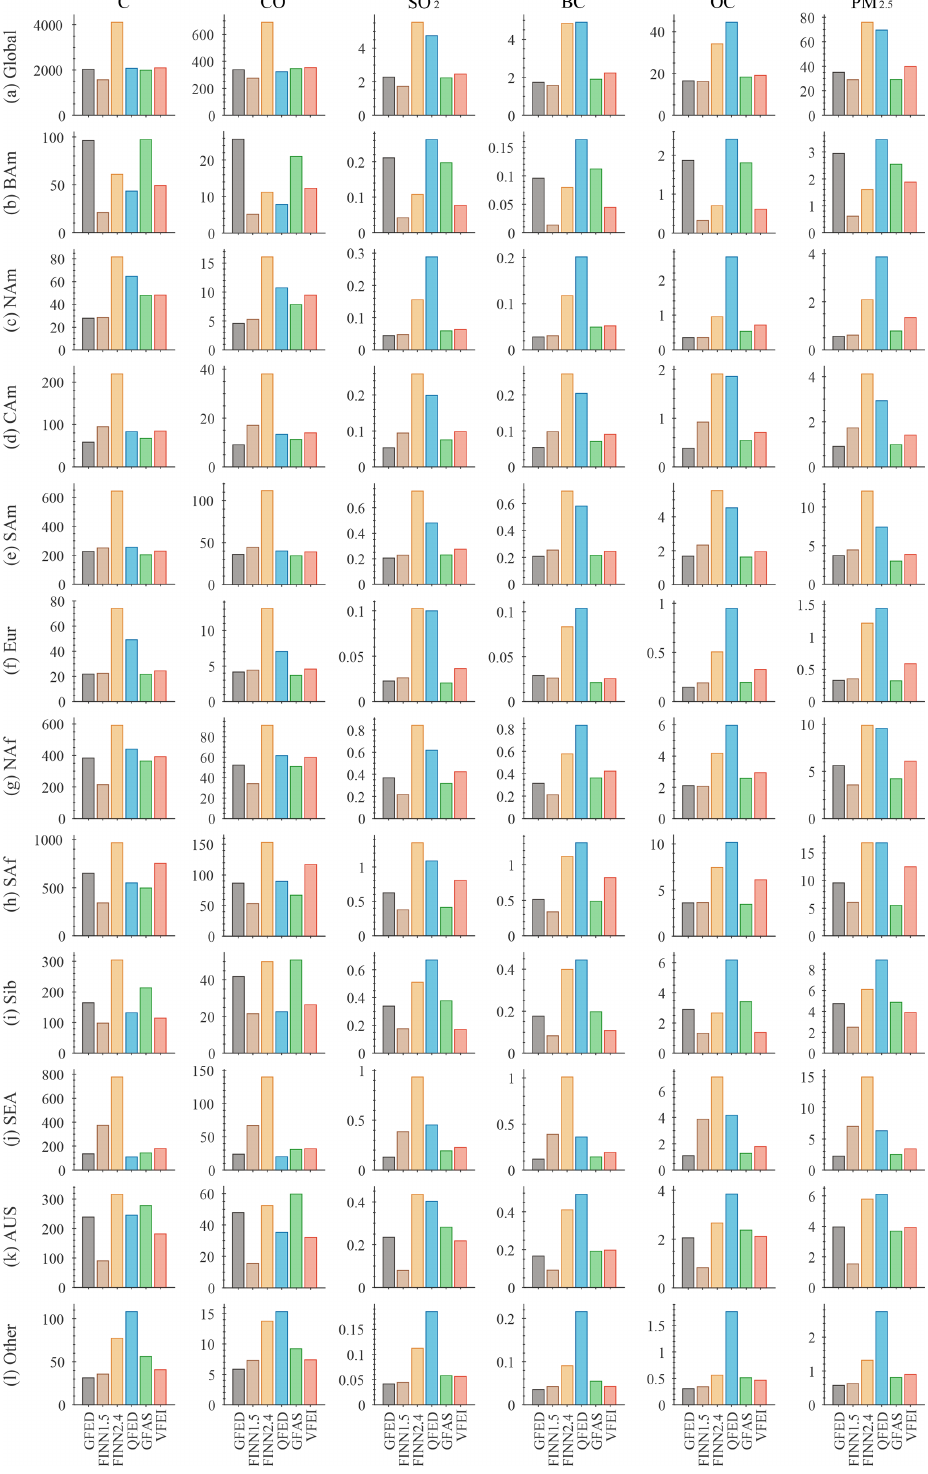
Figure 3. Comparison of average (2012–2019) annual emissions (Tga − 1 ) of VFEI and other inventories for different species in different regions shown in Fig. 2. The species compared are, from left to right, total carbon (C), carbon monoxide (CO), sulfur dioxide (SO 2 ), black carbon (BC), organic carbon (OC), and particulate matter < 2 . 5µm (PM 2 . 5